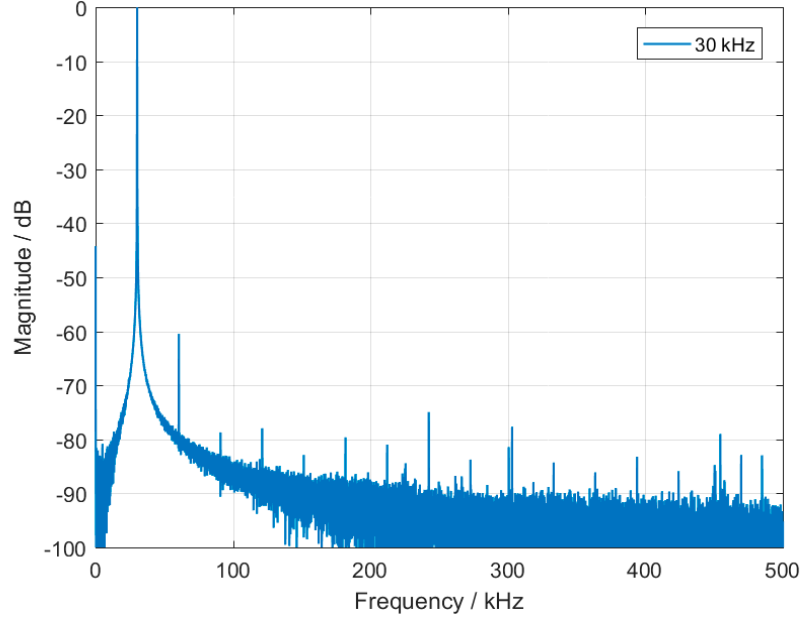
Figure 6. Normalized magnitude spectrum of a 1.5 mA output current signal with a frequency of 30 kHz, measured over a 1 k Ω resistor.